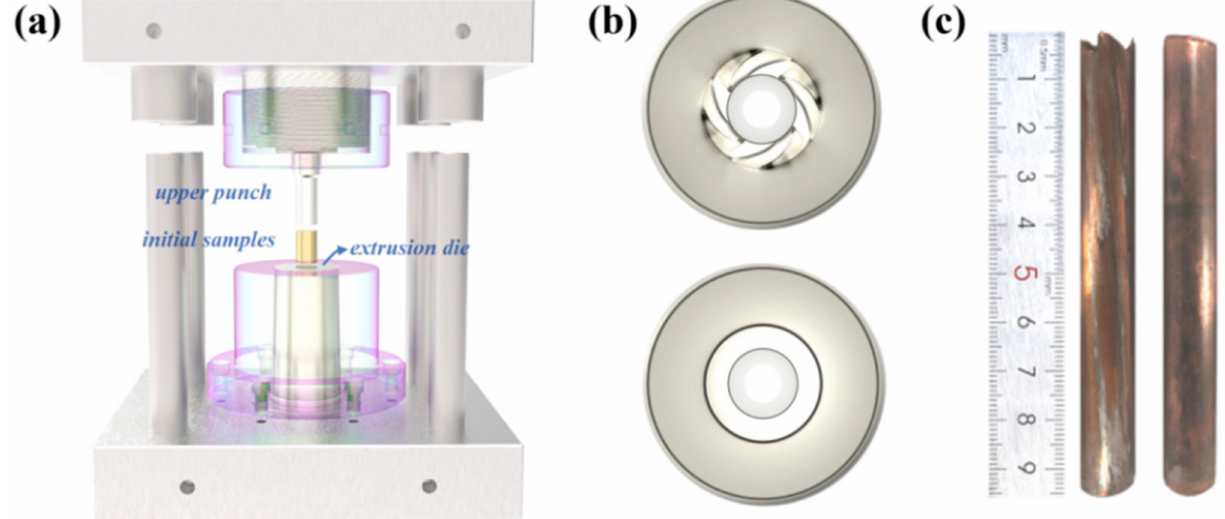
Figure 2. ( a ) Assembled die for FCE and conventional extrusion (CE), ( b ) the extrusion channel of FCE ( upper ) and CE ( bottom ), and ( c ) the sample after FCE ( left ) and CE ( right